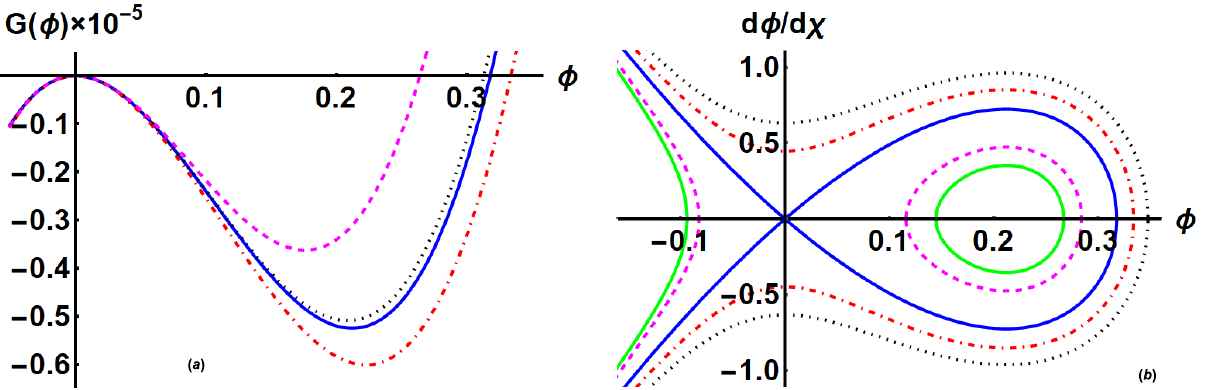
Figure 7. (Color online) ( a ) The variation of Sagdeev potential ( G ( φ )) vs. φ with reference curve (blue solid curve) at µ b = 0.2, V b 0 = 0.4, H = 0.2 and T = 0.2; black (dotted) curve for µ b = 0.24; red (dot-dashed) curve for H = 0.4; magenta (dashed) curve for T = 0.4. ( b ) The case of Q < 0 corresponds to the family of orbits (magenta dashed and green solid curves), Q = 0 represents the solitary wave (blue solid curve) and for H > 0, represents the chain of open orbits with a train of the breaking wave solution (red dot-dashed and black dotted